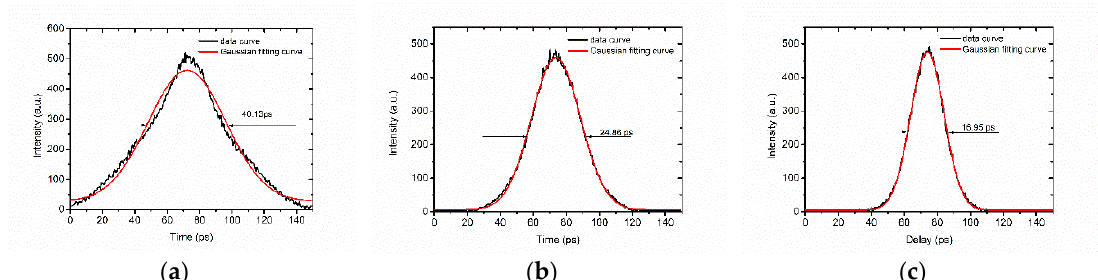
Figure 6. Spectrum measurement of different amplified power outputs.